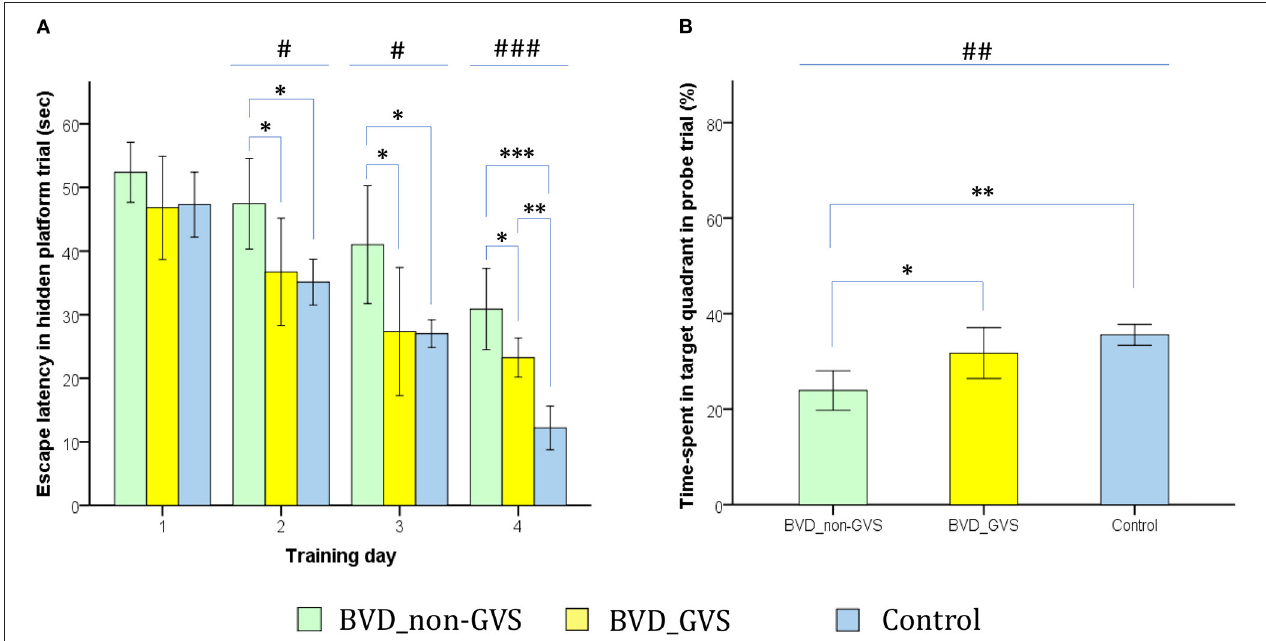
FIGURE 4 | Evaluation of long-term spatial reference memory using the Morris water maze (MWM). The escape latencies to find the hidden platform gradually decreased through the training sessions, indicating ongoing learning. Longer values of escape latency to find the hidden platform indicate an inadequate acquisition of spatial memory and navigation. Differences between the groups were observed on training days (TDs) 2 ( p = 0 .012, ANOVA), 3 ( p = 0 .013, ANOVA), and 4 ( p < 0 .001, ANOVA). The BVD_non-GVS group had longer escape latency than the control group on TDs 2 ( p = 0.022, Bonferroni test), 3 ( p = 0.032, Bonferroni test), and 4 ( p < 0.001, Bonferroni test). The BVD_GVS group had shorter escape latency than the BVD_non-GVS group on TDs 2 ( p = 0.037, Bonferroni test), 3 ( p = 0.028, Bonferroni test), and 4 ( p = 0.024, Bonferroni test) (A) . Residual impairments in long-term spatial memory were also indicated by a lower percentage of